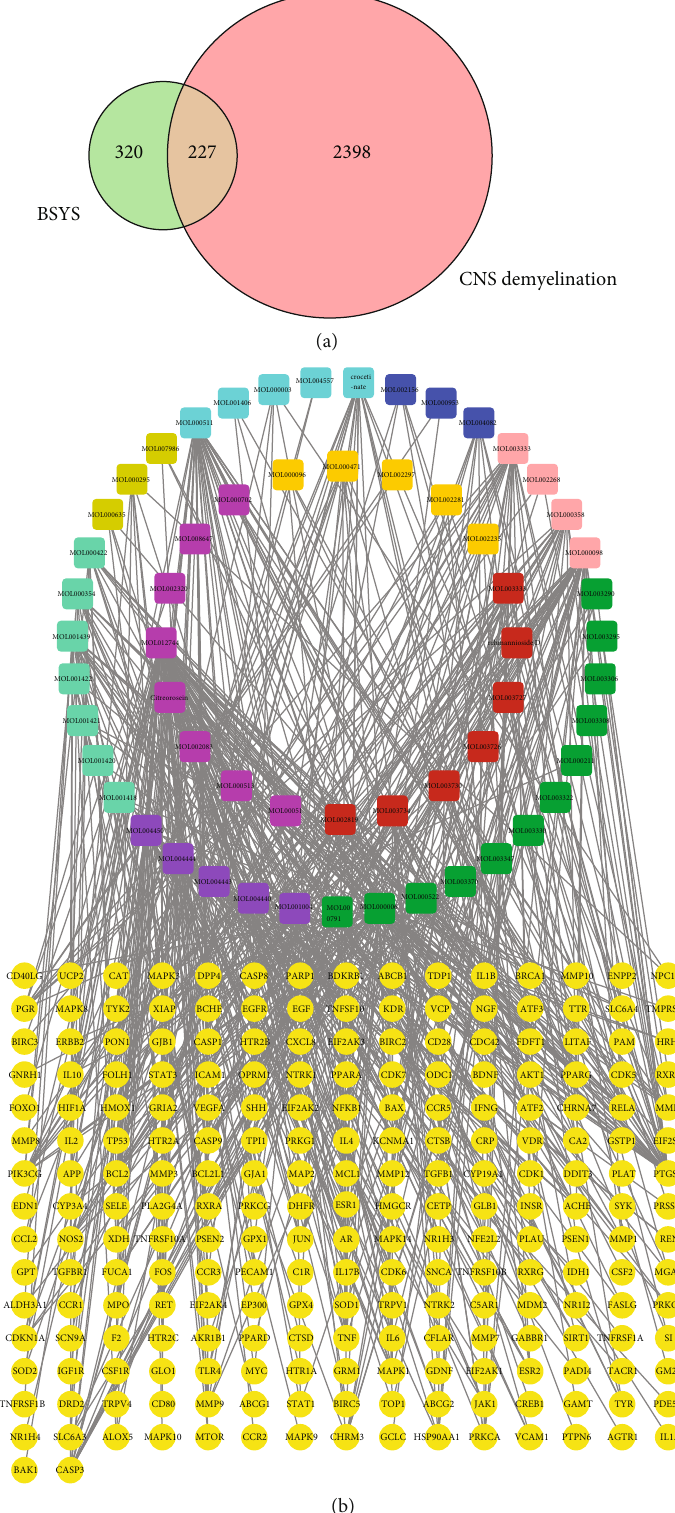
Figure 2: BSYS Capsule and CNS demyelination-related targets and overlapping targets. (a) Venn diagram of screened intersection targets of BSYS Capsule and CNSD-related targets. (b) Active ingredient-intersection target network. Circles of various colors and yellow squares represent the targets and ingredients, respectively. Di ff erent colors represent ingredients from di ff erent herbs, which is consistent with Figure